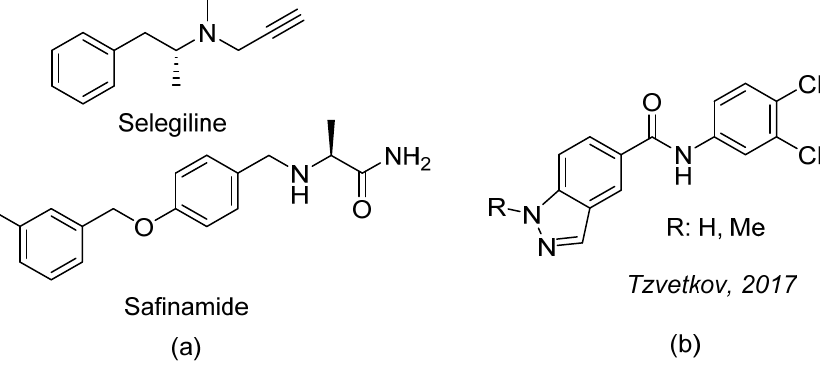
Figure 1. ( a ) Structures of MAO-B-specific inhibitors; ( b ) the series of indole and indazole derived MAO inhibitors.